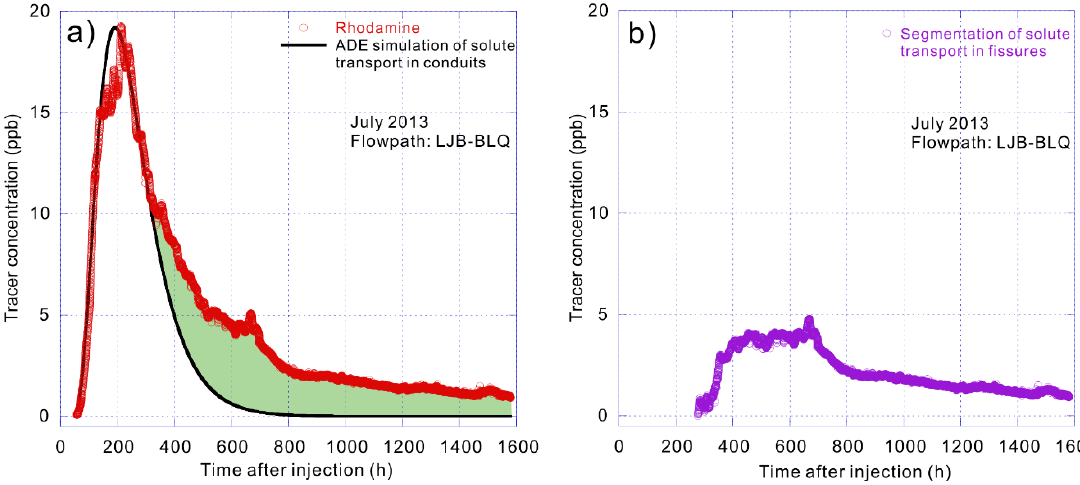
Figure 3. ( a ) Breakthrough curve of LJB–BLQ (Liujiaba-Bailongquan) and the fitting curve of solute transport in conduit flow using advection–dispersion equation (ADE). ( b ) Segmentation of